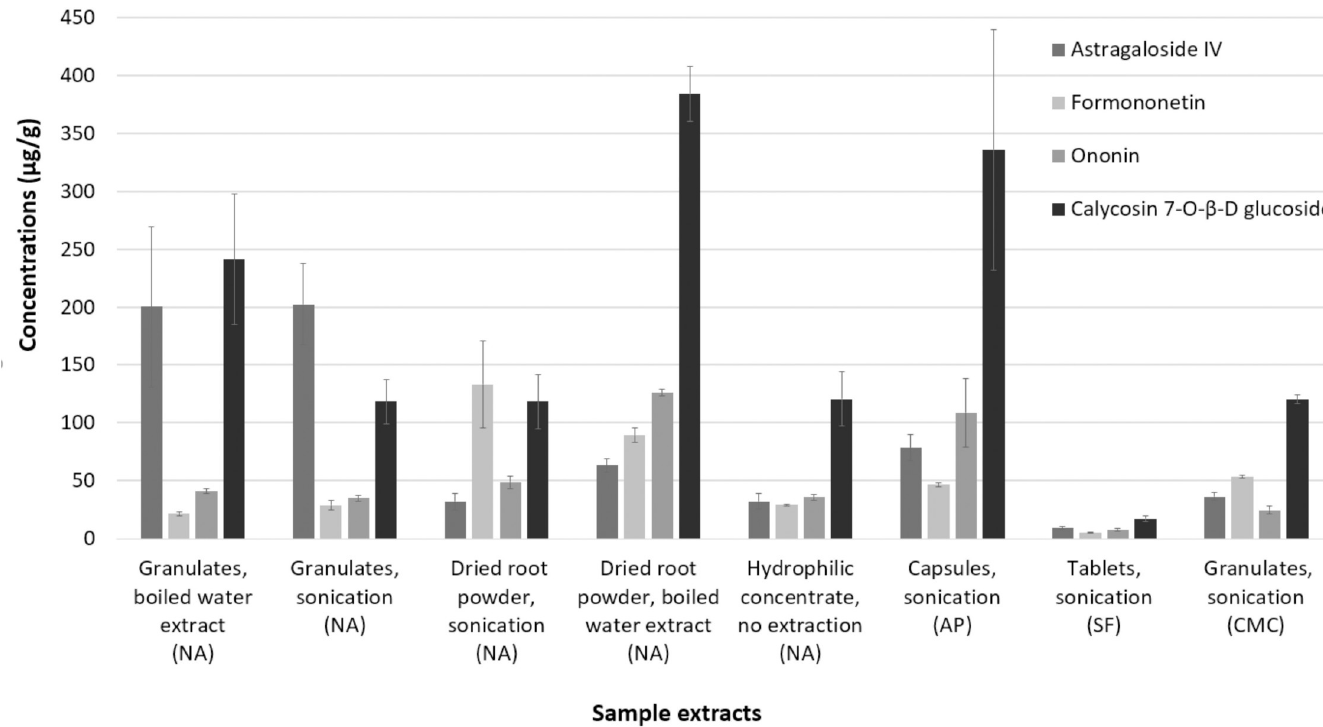
Fig 2. Histogram showing the concentrations of biologically active components (mean ± SD) present in AR samples from different vendors.